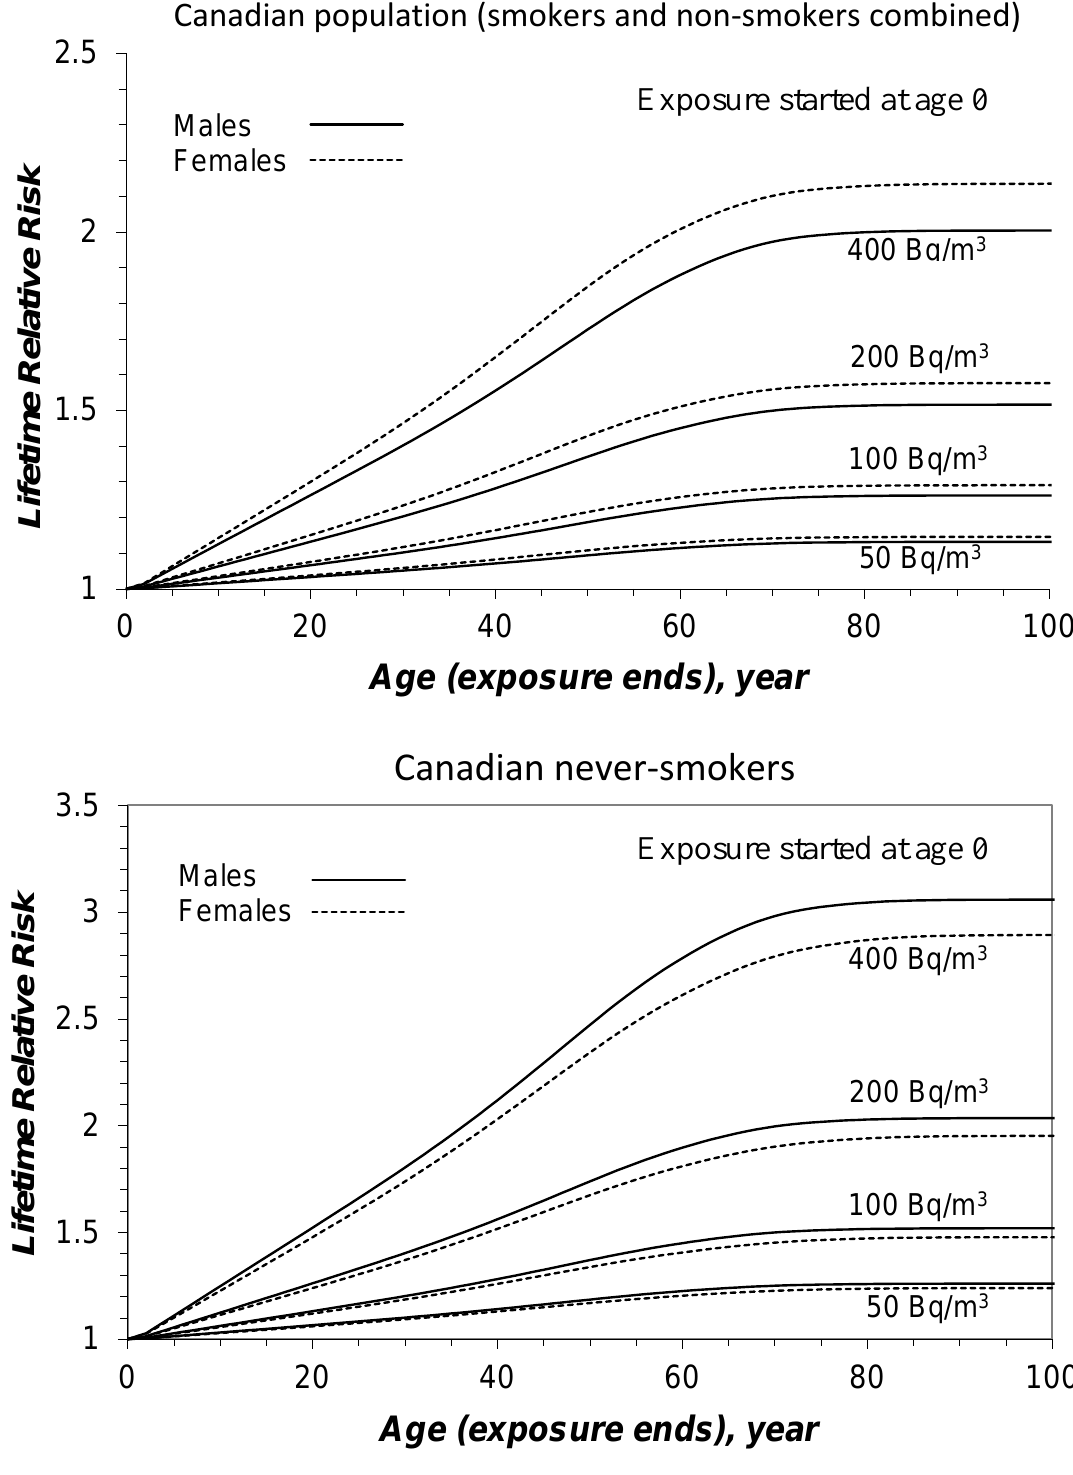
Figure 2. Lifetime relative risk as a function of age when exposure ends, for exposures to radon concentrations of 50, 100, 200, and 400 Bq/m 3 (upper panel for Canadian population—A mixture of smokers and non-smokers; lower panel for male and female